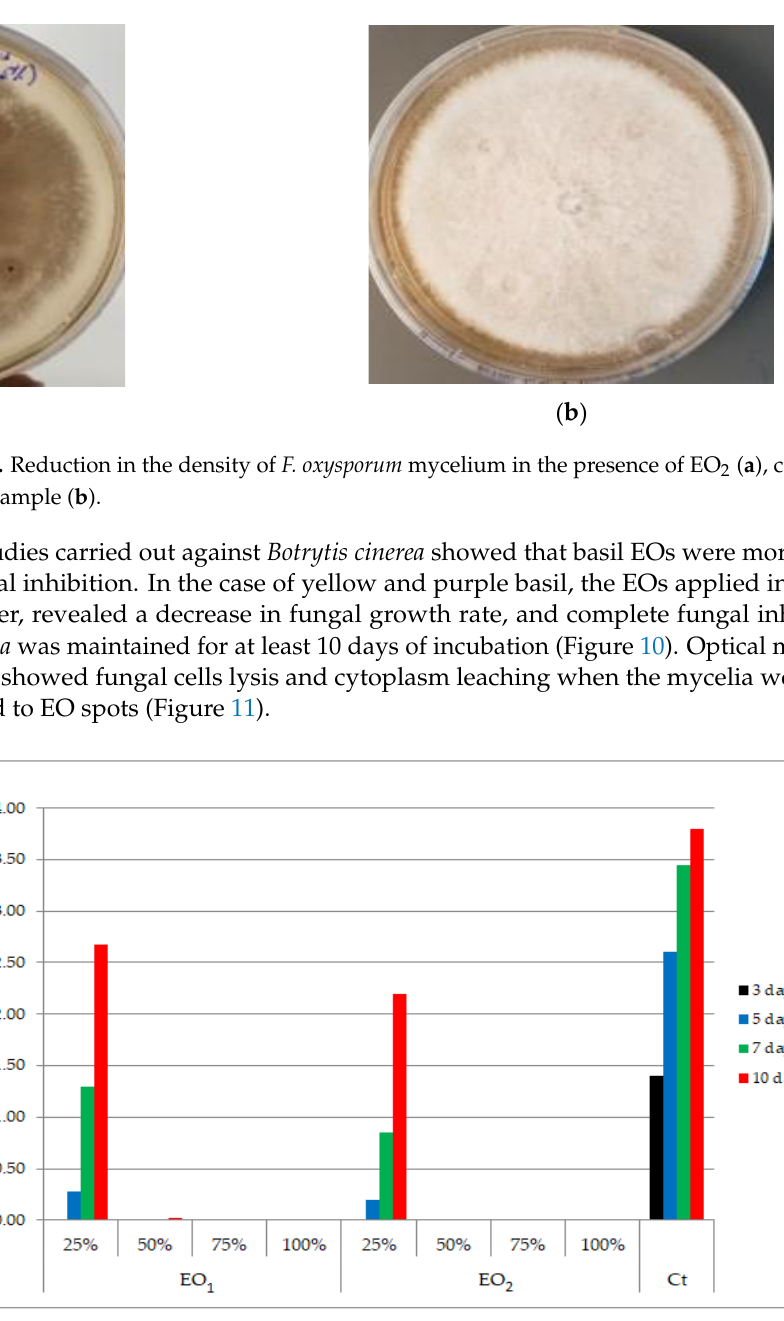
Figure 10. Basil essential oils (EOs) evaluation against the pathogen B. cinerea on CGA medium, tested at different concentrations.